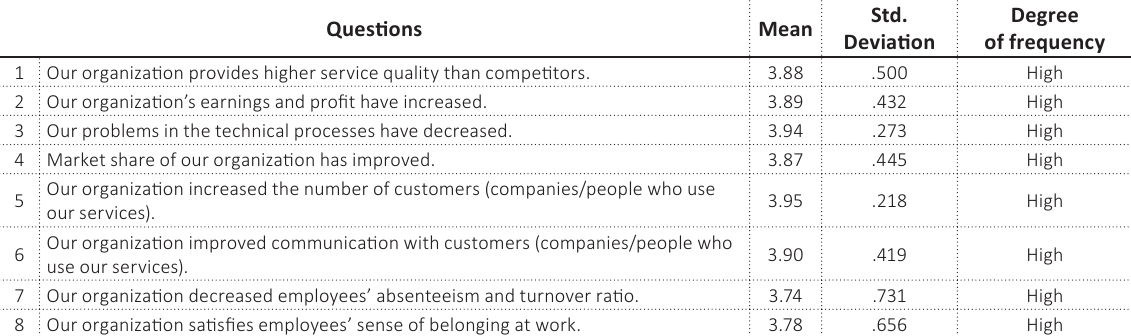
Table 4. Descriptive statistics for organizational